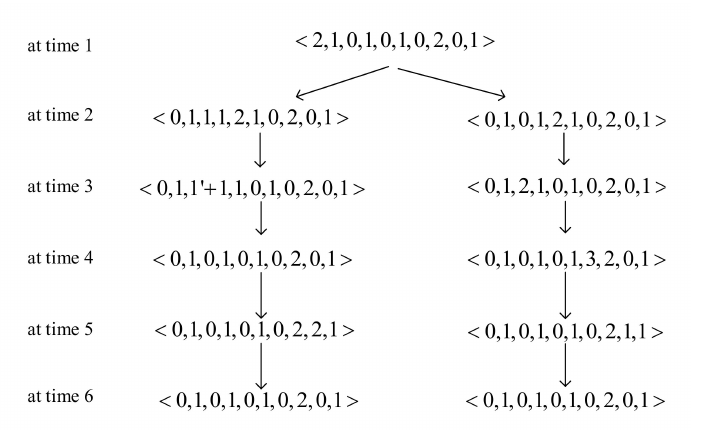
Figure 4. The configuration of the example at each